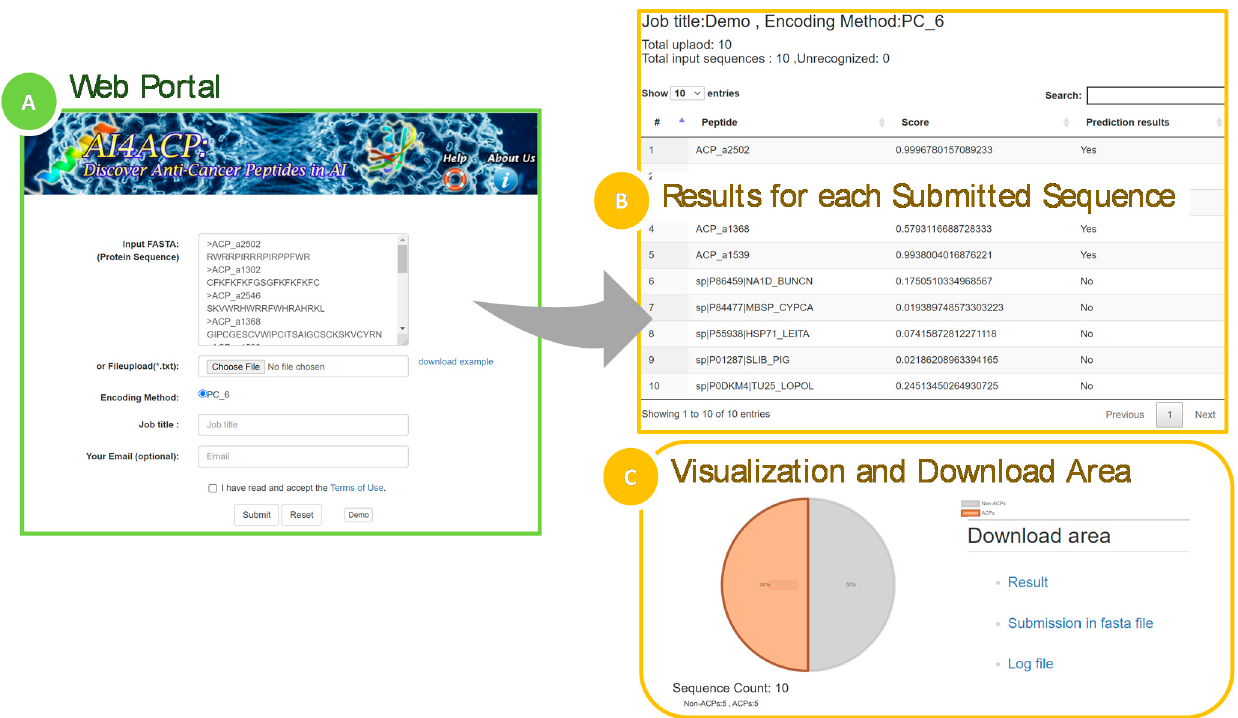
Figure 7. AI4ACP website. ( A ) The web portal of AI4ACP for sequence submission in FASTA. ( B ) The output of ACP activity for each submitted sequence with a prediction score. ( C ) Pie chart presents the prediction of the whole submissions and the submission with files generated during the prediction.